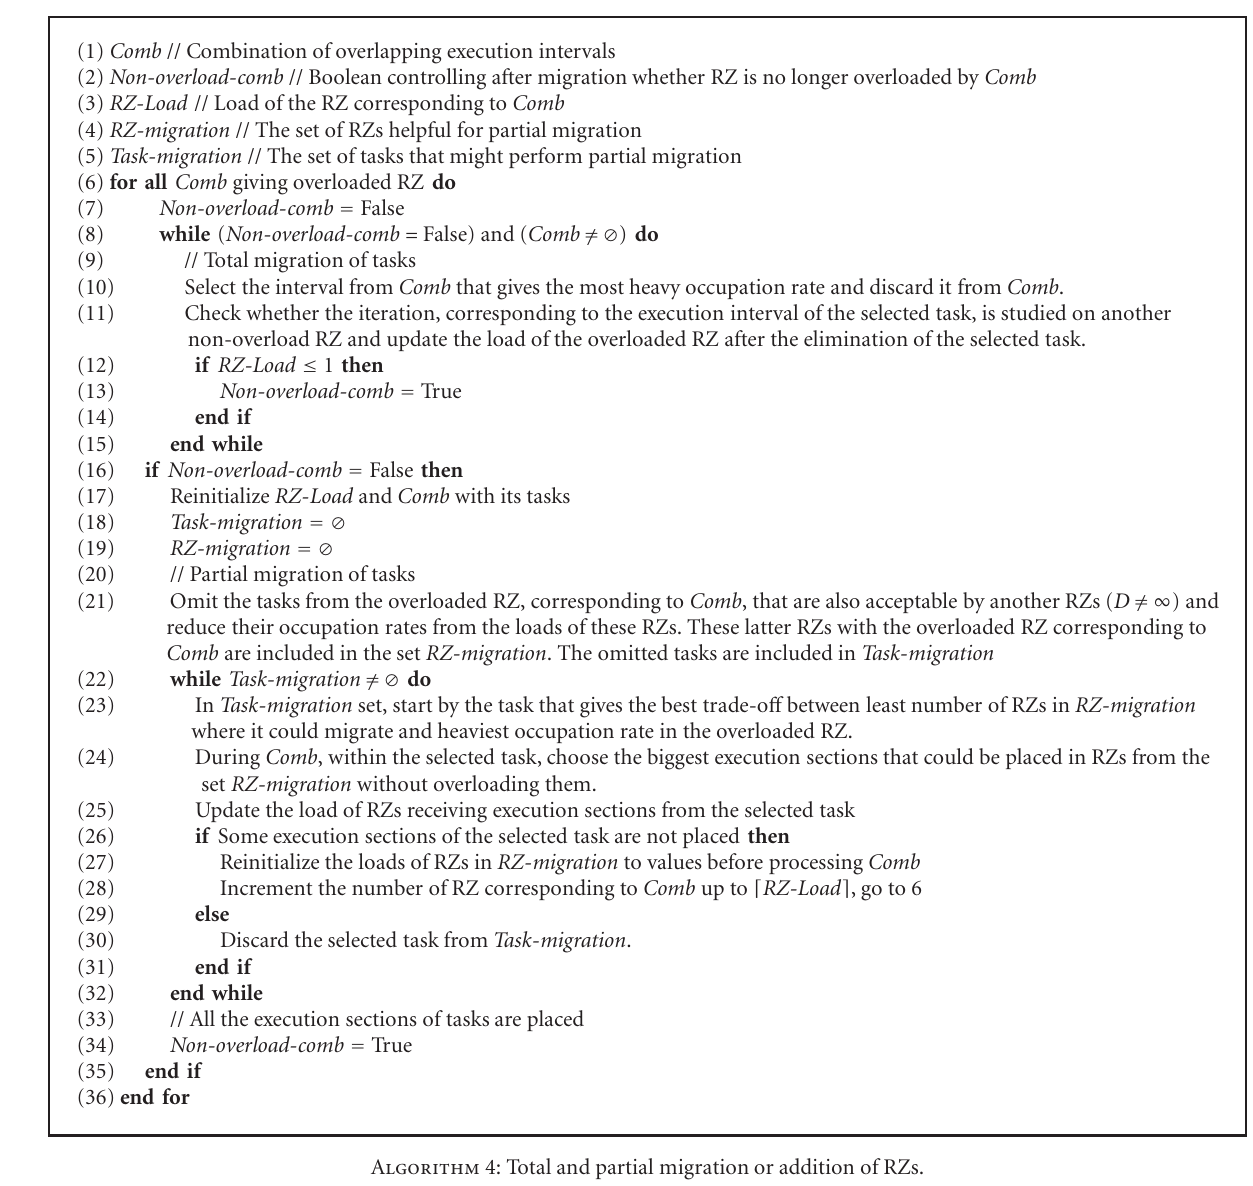
Algorithm 4 attributes weights to tasks within Task -